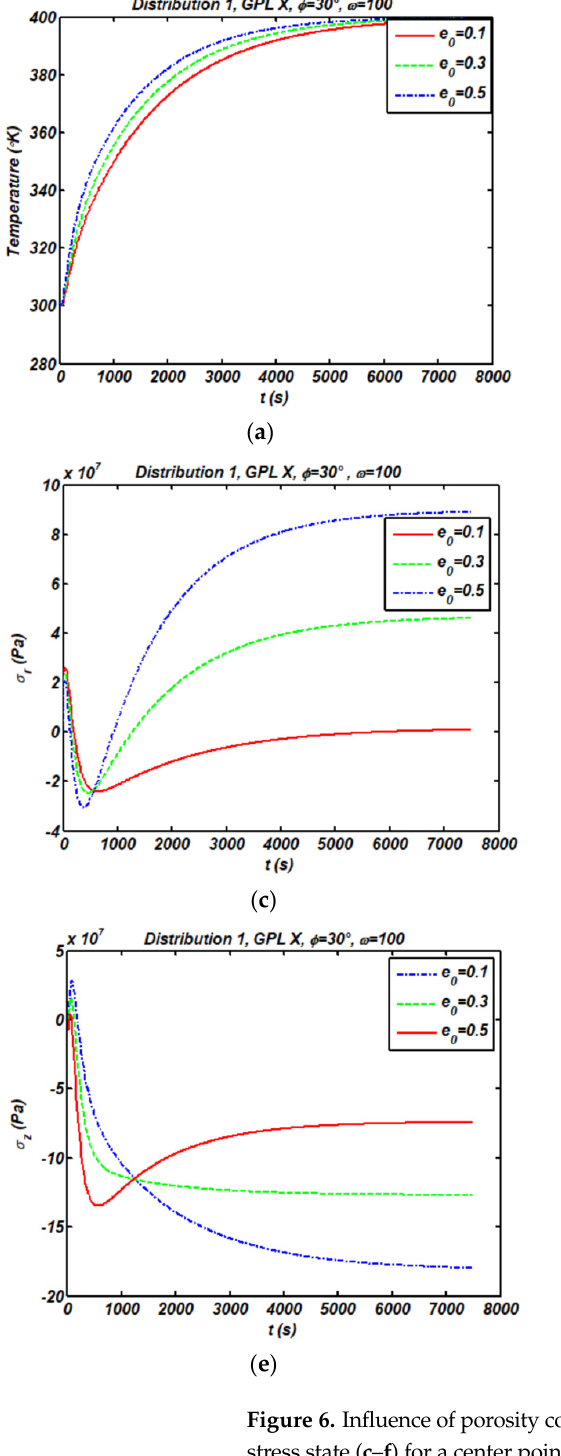
Figure 5. Influence of semi-vertex angle on the transient temperature ( a ), radial displacement ( b ), and stress state ( c – f ) for a center point of truncated cone (D1-GPL X; 0 e = 0.4; GPL 100 rad/s).